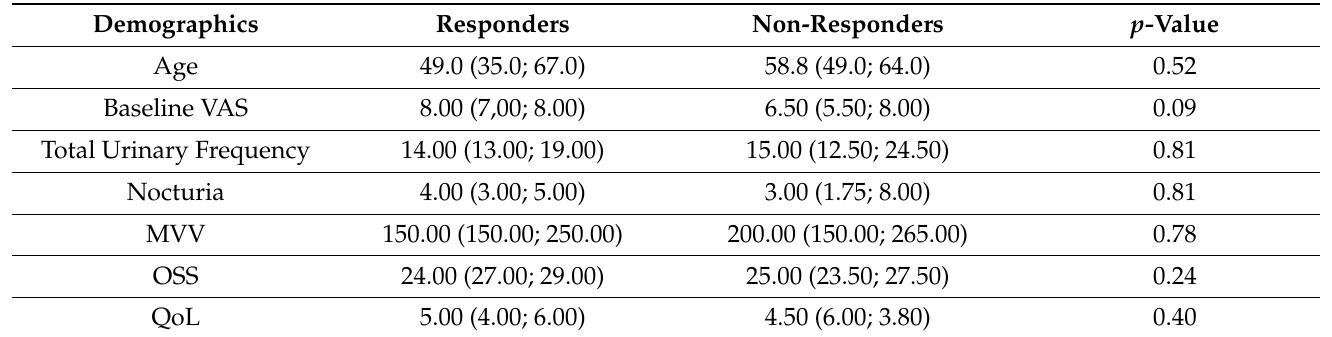
Table 2. Comparison of demographic characteristics between patients that reached the primary end- point (responders) and those who did not (non-responders).